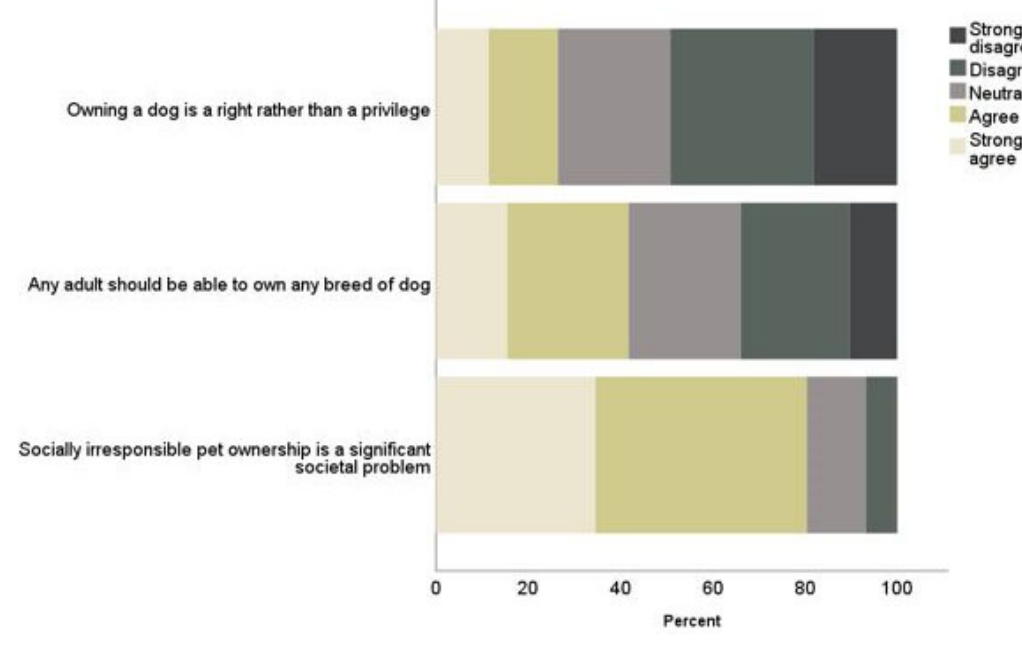
Figure 3. Perceptions of pet ownership.